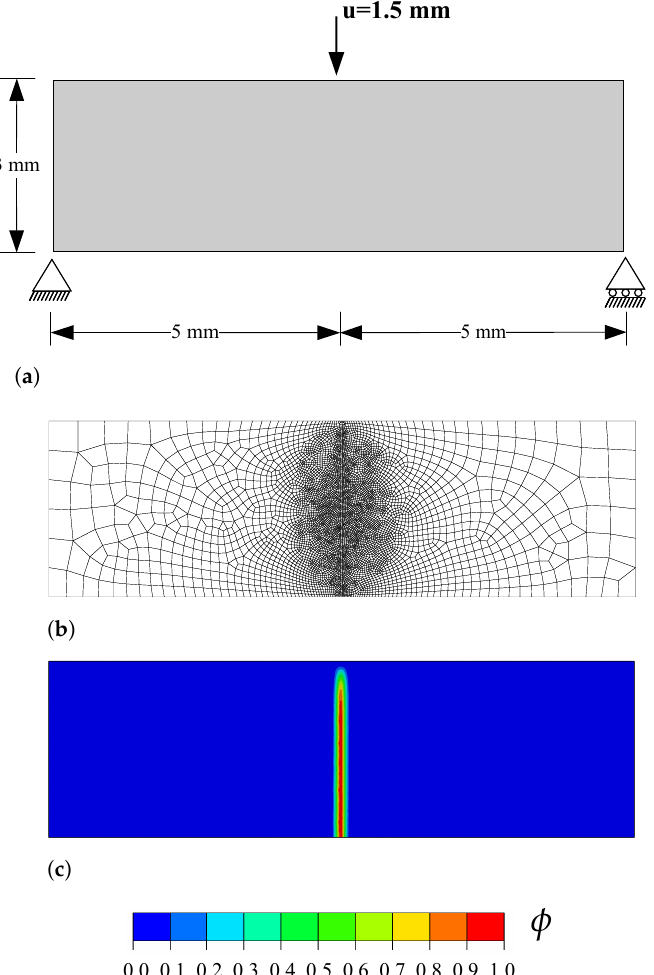
Figure 1. Three-point bending test: ( a ) geometry, dimensions and boundary conditions, ( b ) finite element mesh, and ( c ) phase field contour at the end of the